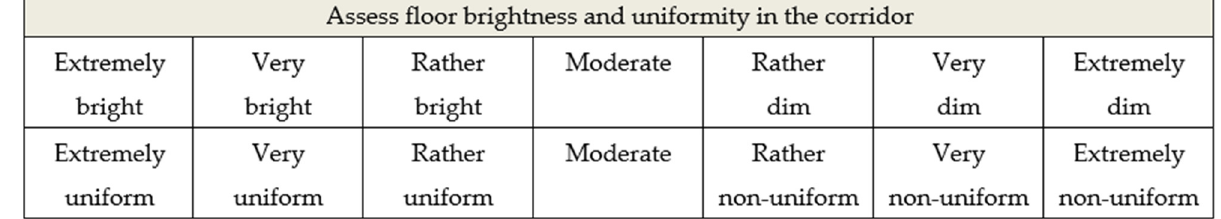
Figure 2. Part of questionnaire concerning the assessment of floor brightness and uniformity illumination in the corridor.